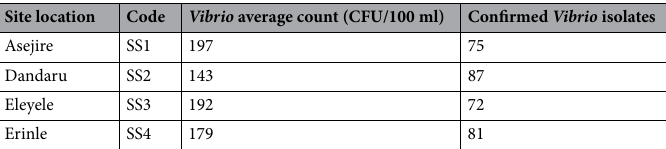
Table 1. Number of confirmed Vibrio isolates.